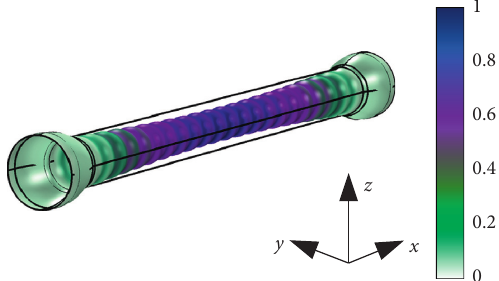
Figure 9: Expansion-contraction mode shape of the busbar shell at 2883Hz in COMSOL.